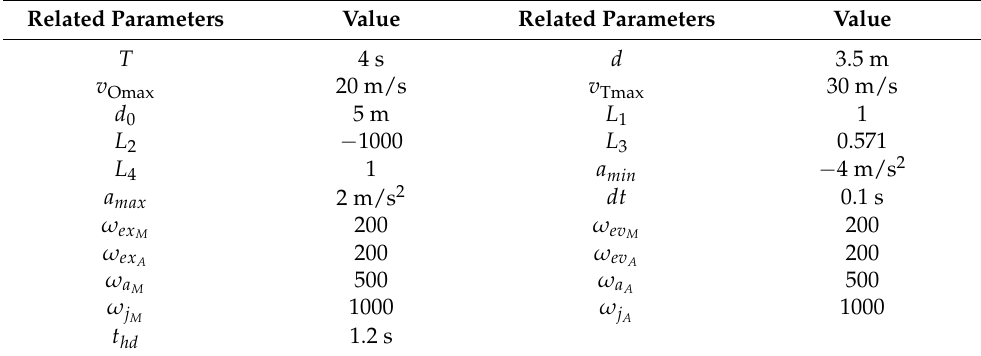
Table 1. Related parameters in the simulations. Related